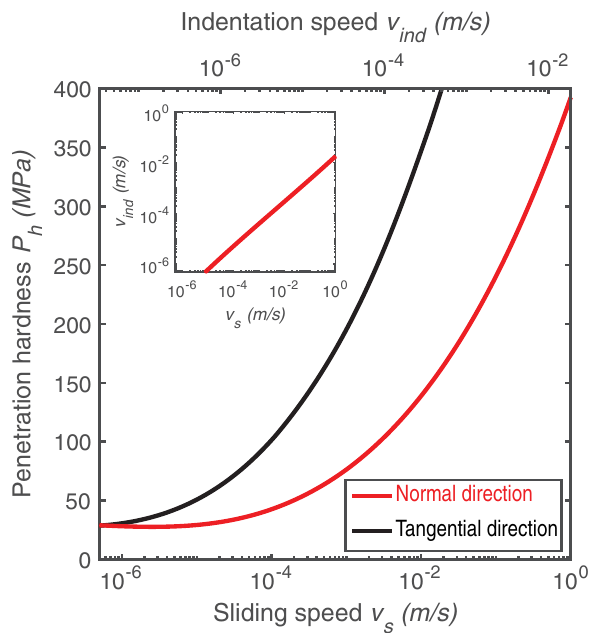
FIG. 7. Penetration hardness in the normal direction (red) and tangential direction (black) as a function of sliding speed for ice at a temperature of − 20 °C based on Eq. (A2). The calculated indentation speed corresponding to the set sliding speed is given in the inset and as top axes for sliding a glass sphere ( R ¼ 1 . 84 mm) at a normal force of 2.5 N over ice at − 20 °C, Eq. (B5). The indentation speed is around 4% of the sliding speed, and consequently, the penetration hardness in the normal direction is smaller than the penetration hardness in the tangential direction.